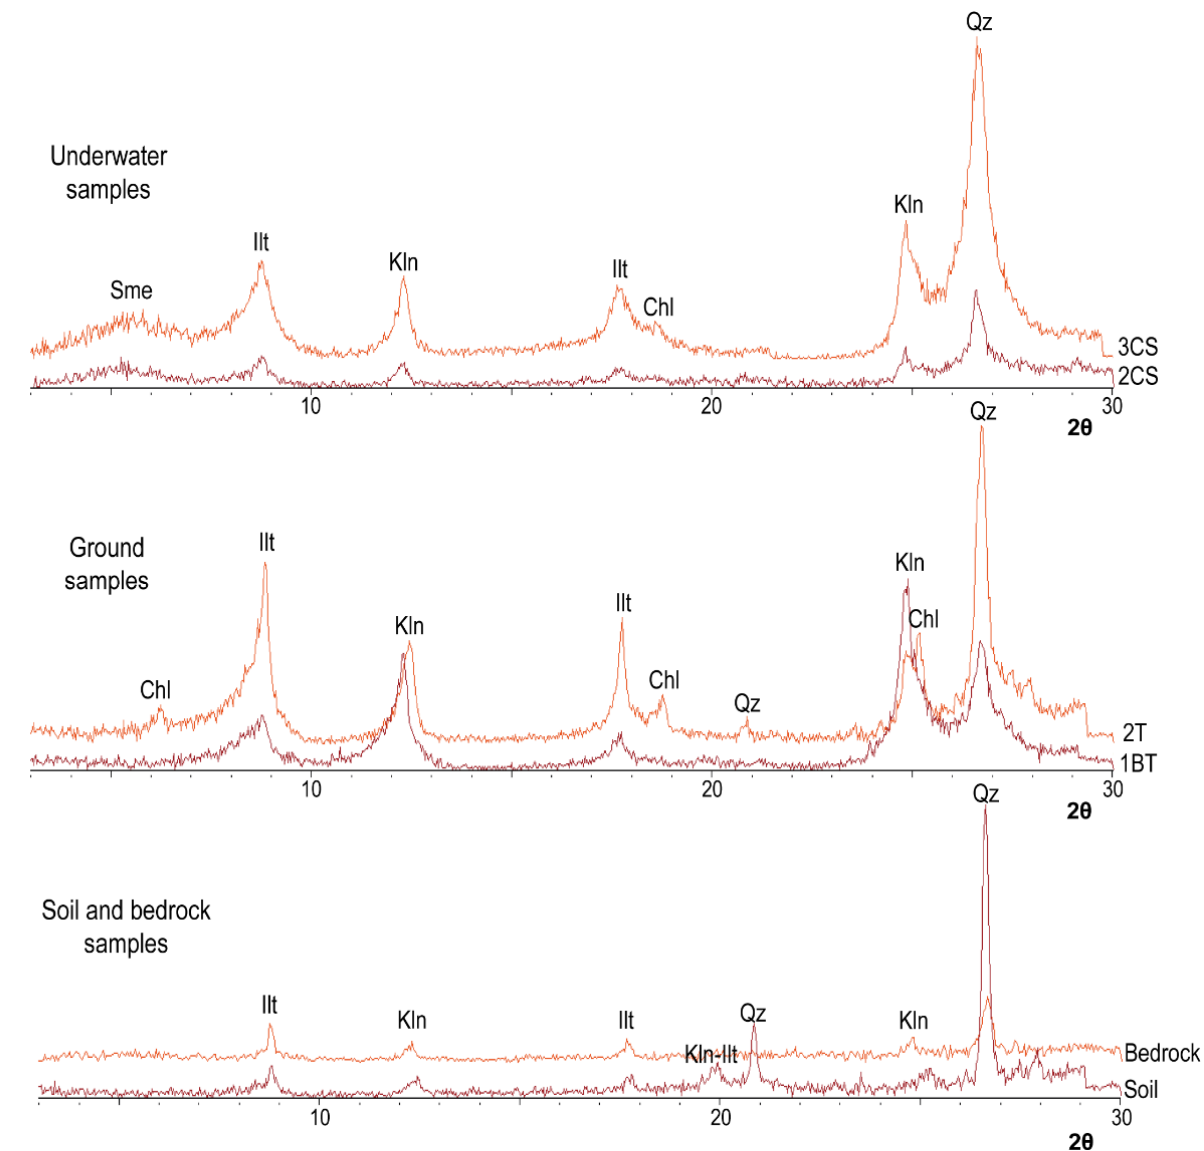
Figure 3. Representative XRD patterns obtained from the <2 μ m fractions in submerged samples, terrestrial samples, the bedrock and the soil samples. Qz = Quartz; Ilt = Illitic phases; Kln = Kaolinite, Chl = Chlorite; Sme = Smectite.